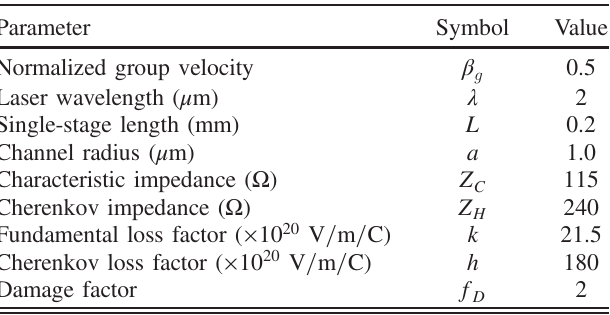
TABLE II. Structure parameters corresponding to a cylindrical Bragg geometry [27]. Parameter Symbol Value Normalized group velocity β